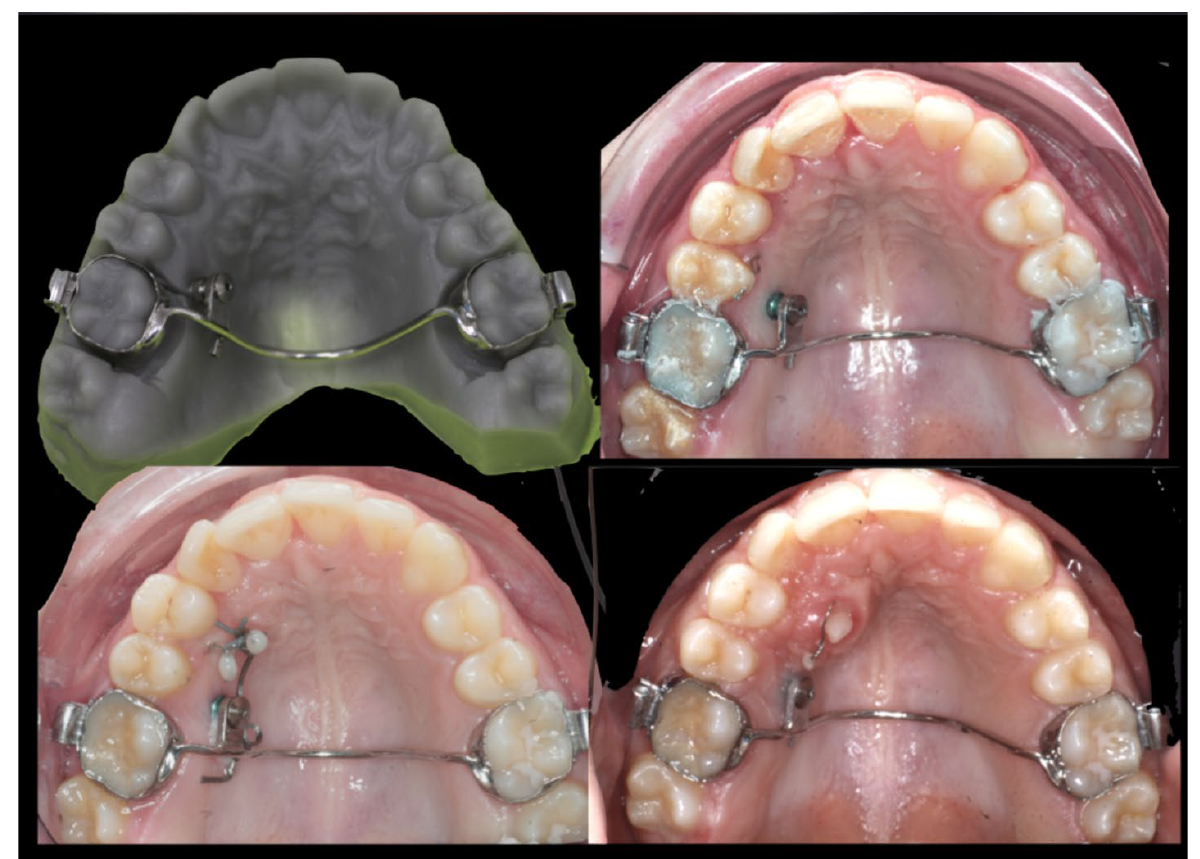
Figure 1. mTPA: indirect anchorage with digitally planned TPA anchored to miniscrews.